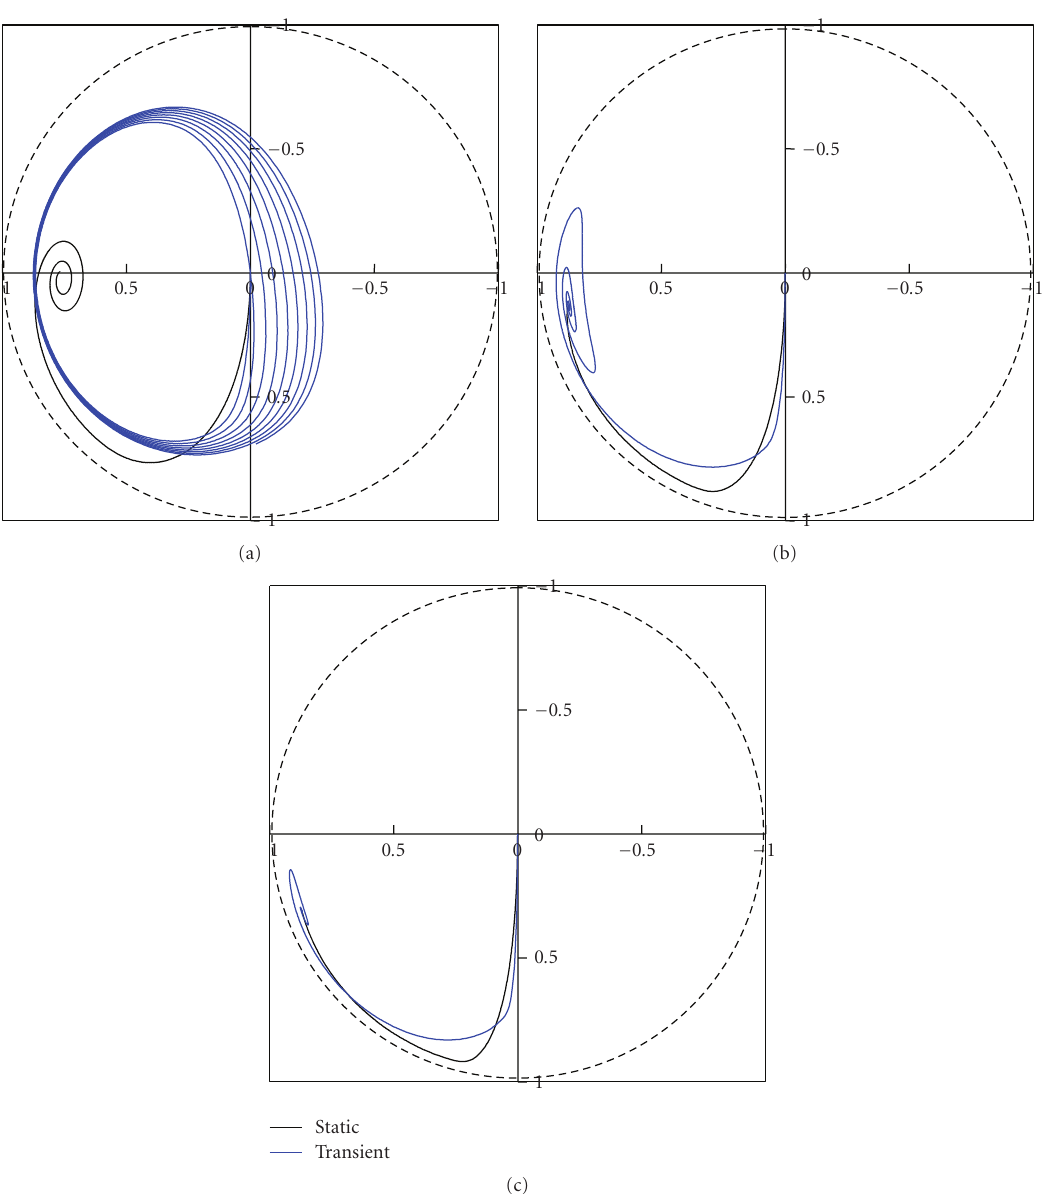
Figure 2: Trajectories path of rotor’s center (expressed as a ration of rotor centre position over bearing clearance), comparison between transient and static results for plain circular journal bearing, Ω = 1000rpm, c = 40 μ m, l 0 = 25mm, and r 0 = 15mm, with loads of (a) 56.65g, (b) 113.4g, and (c)